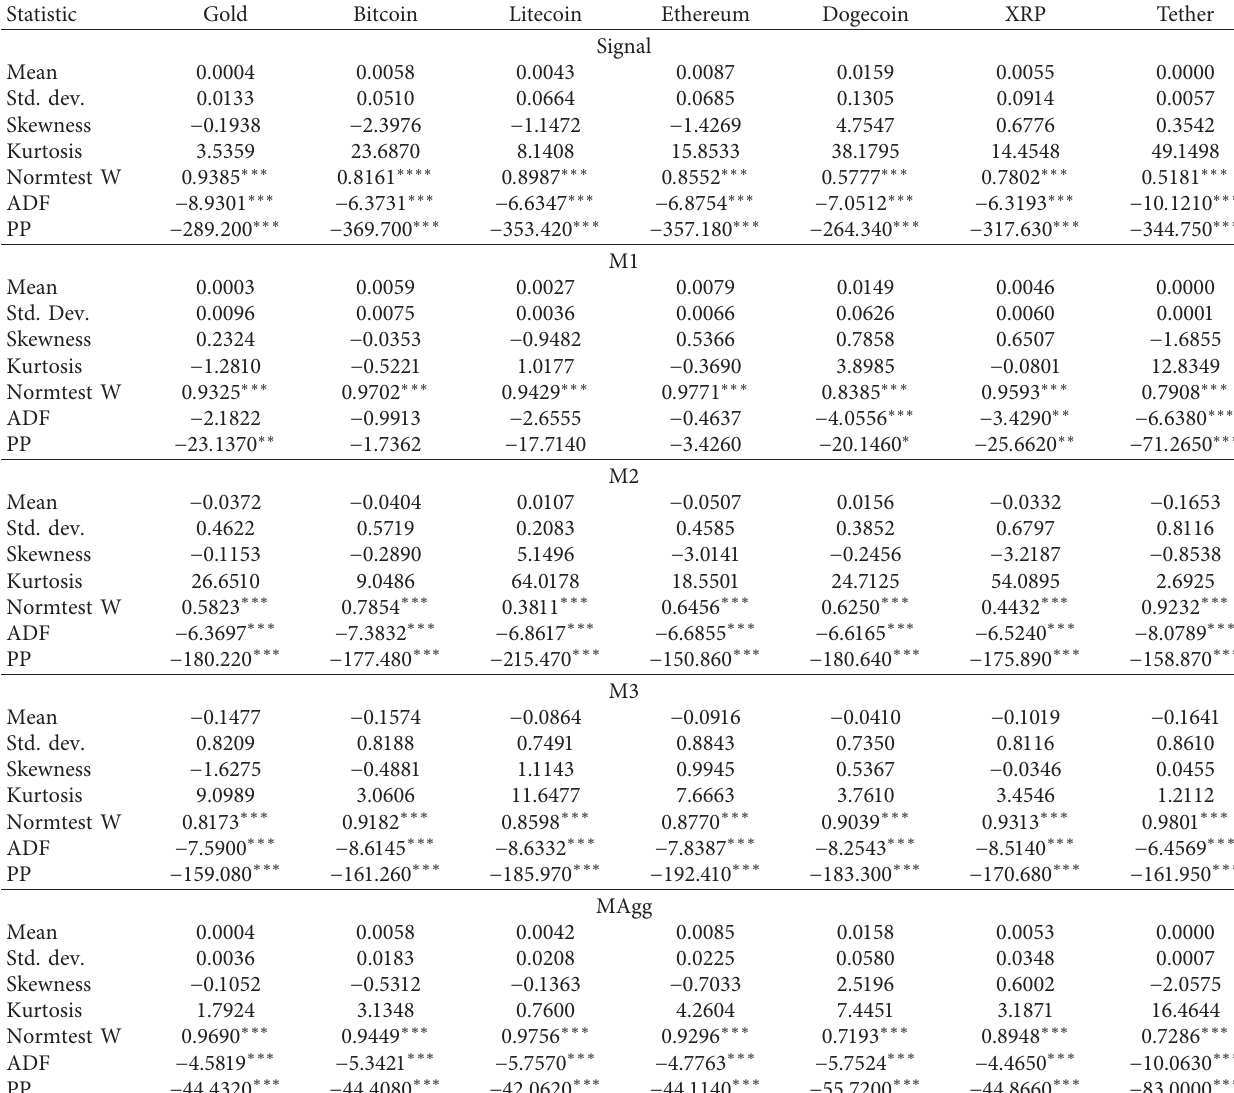
Table 1: Summary